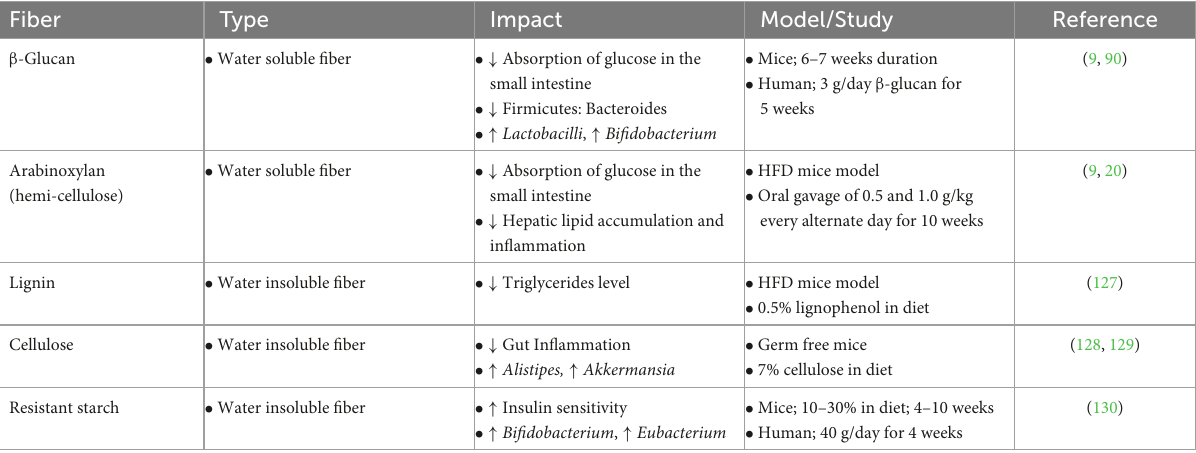
TABLE 4 Known anti-diabetic and gut-microbiota modulatory effects of different dietary fibers in finger